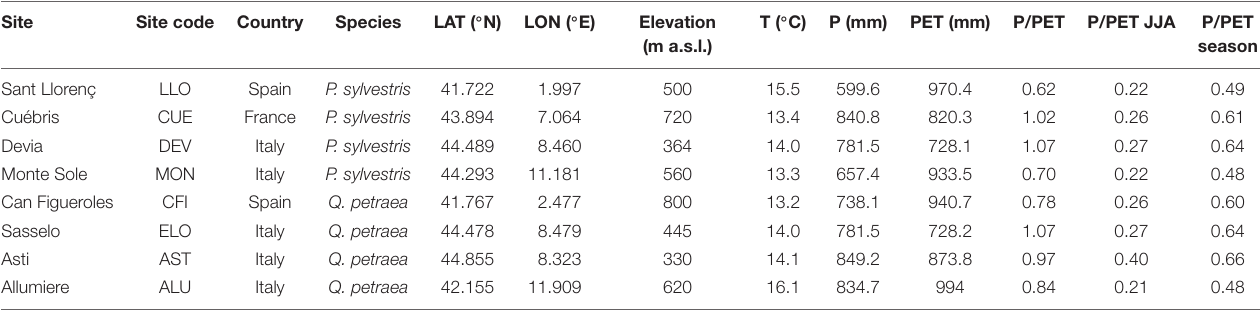
TABLE 1 | Geographical characteristics of the study sites and mean climatic variables derived from E-OBS dataset for the studied period (2011–2014) corresponding to the build-up time of the sampled branches. Site Site code Country